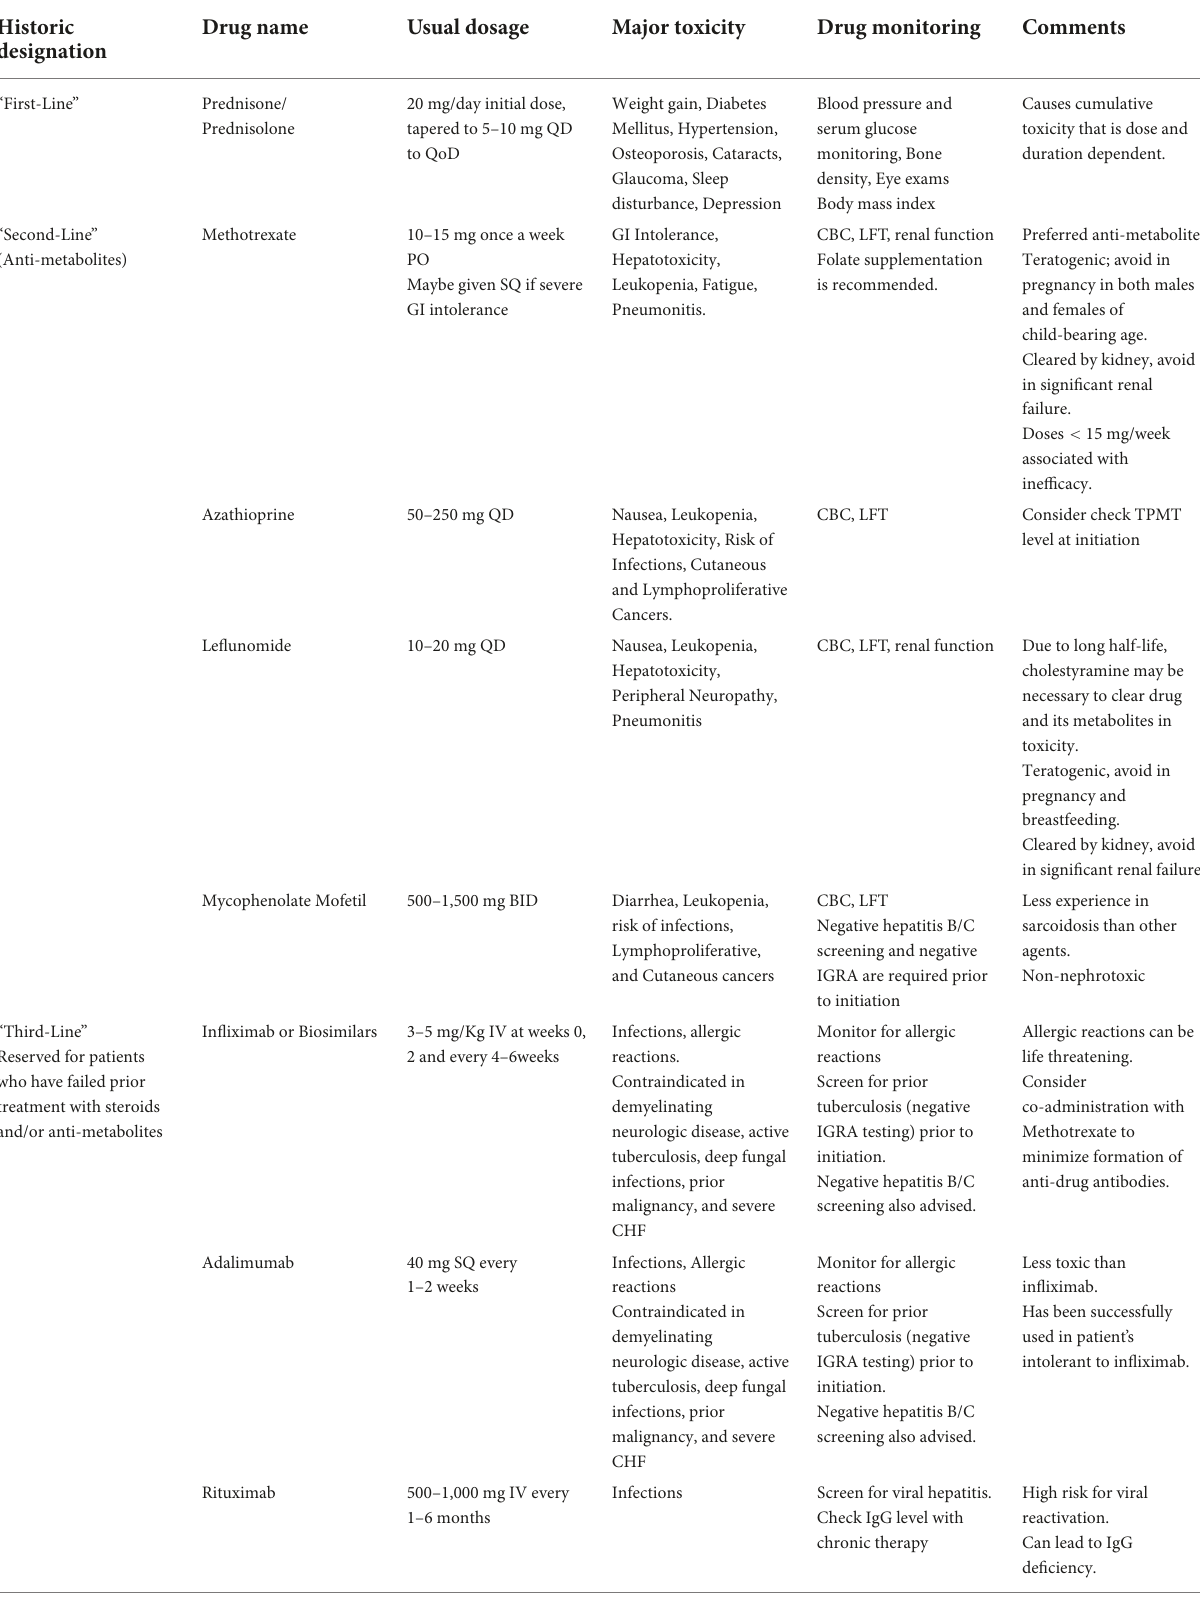
TABLE 1 Current widely accepted stepwise medications for the treatment of Sarcoidosis (5, 7, 48,